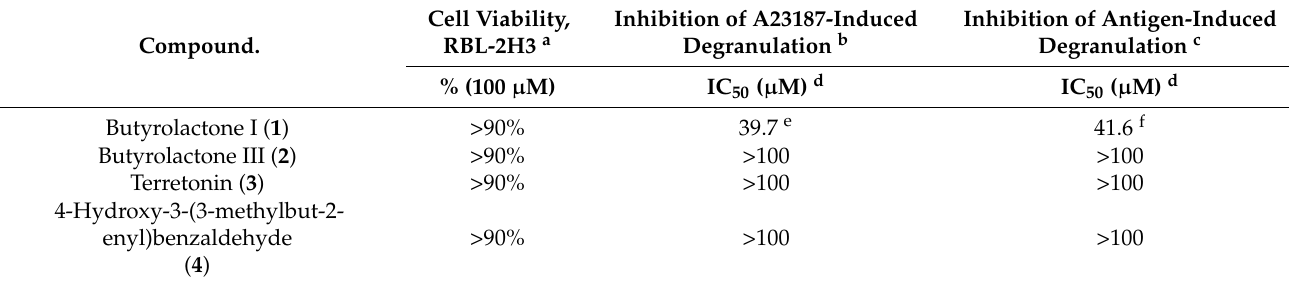
Table 1. Inhibitory activity of butyrolactone I ( 1 ) on A23187- and antigen-induced degranulation.